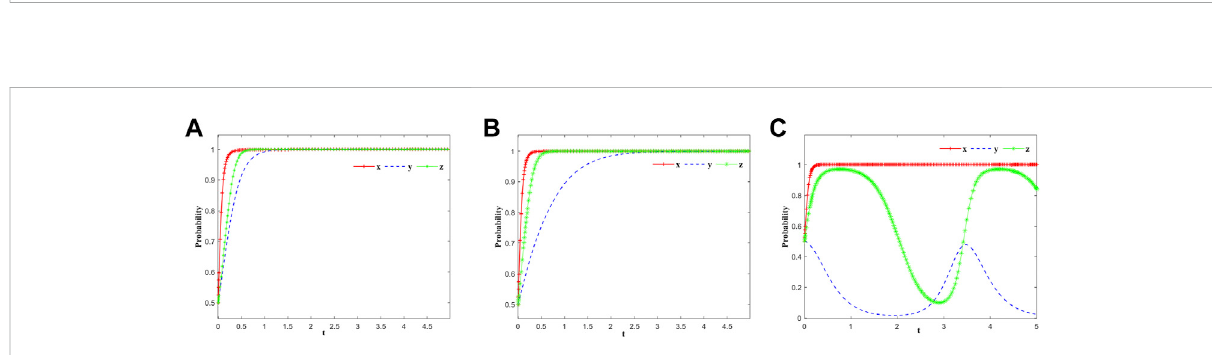
FIGURE 6 Simulation of the evolutionary strategy of the three parties under different local government subsidies to enterprises. Note: t denotes the time, i.e., the speed of achieving low-carbon treatment, and S = 2, 5, 10 in Panel 6 (A – C) , respectively, denote the subsidies from the local government to the enterprise from small to